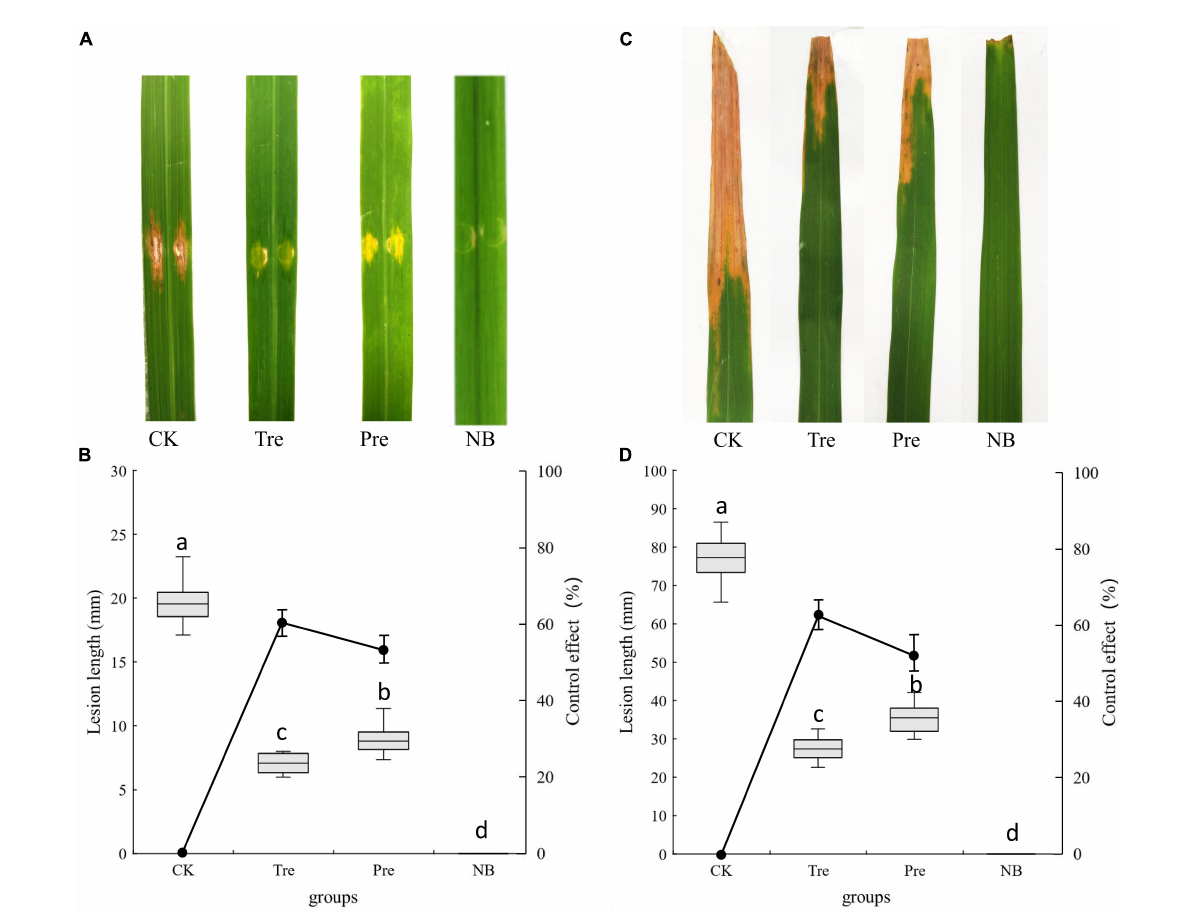
FIGURE8 Effect of B. velezensis BR-01 on inhibition of rice bacterial leaf streak and rice bacterial blight under greenhouse conditions. (A) Representative lesions on rice leaves of rice bacterial leaf streak. (B) Lesions length of rice bacterial leaf streak and biocontrol effect of B. velezensis BR-01. (C) Representative lesions on rice leaves of rice bacterial blight. (D) Lesions length of rice bacterial blight and biocontrol effect of B. velezensis BR-01. Different lowercase letters represented significant difference ( P <